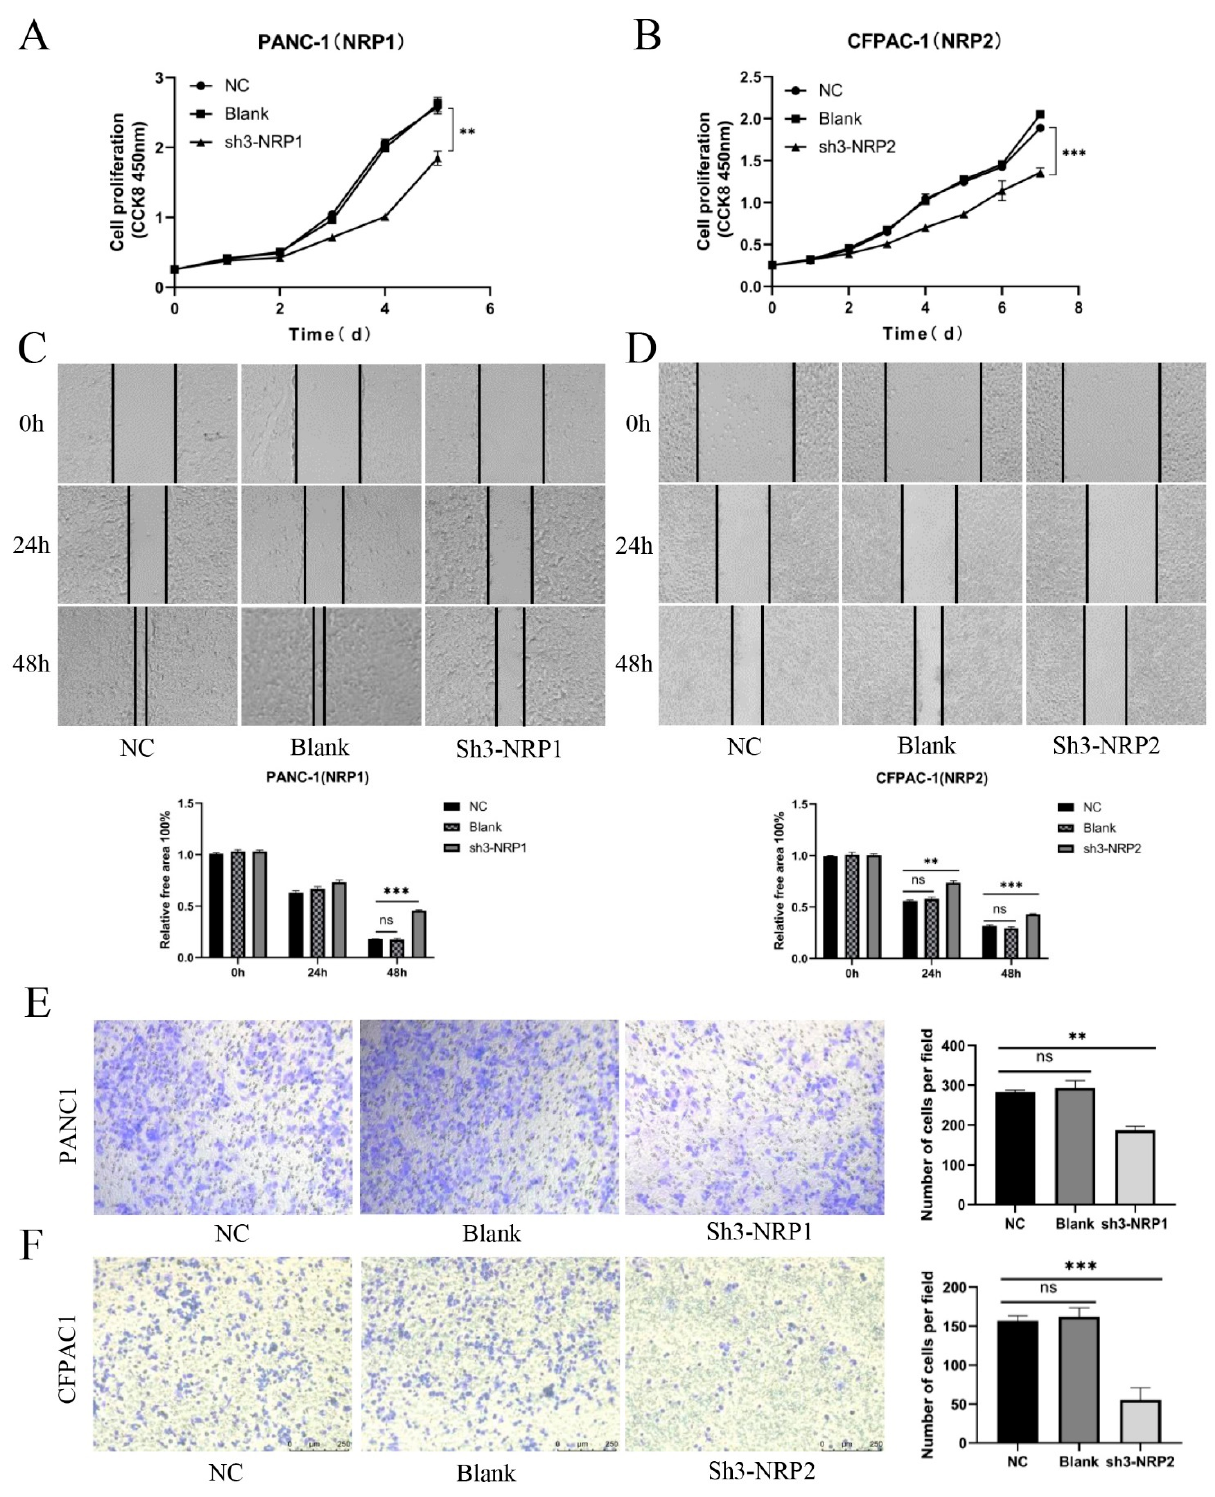
Figure 6. In vitro experiments. ( A , B ) CCK8 assay for the proliferation of PAAD cells after NRP gene silencing. ( C , D ) Wound-healing assay for the migration of PAAD cells after NRP gene silencing. Magnification 50×. ( E , F ) Transwell assay for the invasion of PAAD cells after NRP gene silencing. NC, negative control; Blank, not transfected. Magnification 50×. All experiments take the NC group as the reference. ** p < 0.01 and *** p < 0.001; ns, not significant.